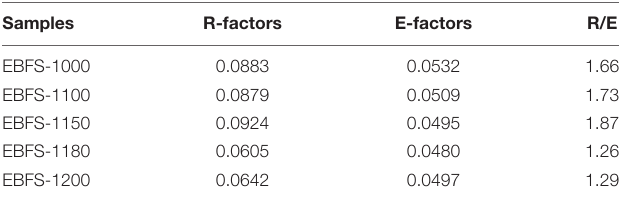
TABLE 2 | Refinement factors and R/E values of EBFS